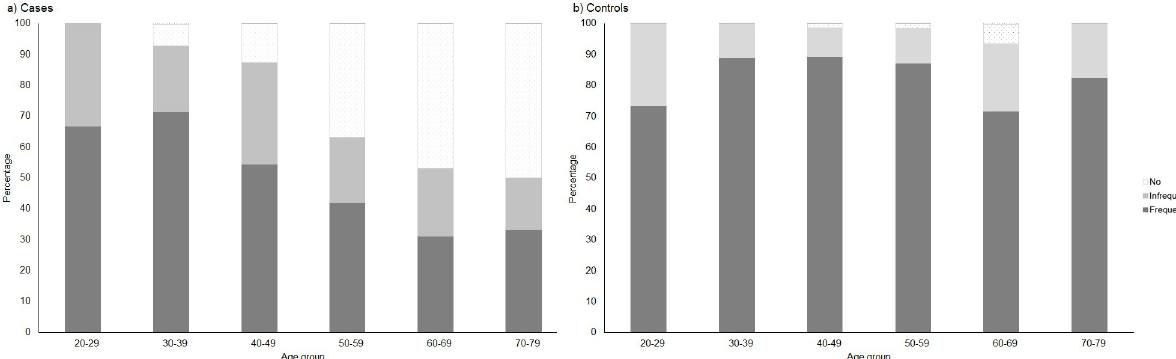
Fig 2. Participation in cervical cancer screening during the past ten years among cases and controls, according to age group. Frequent: at least every three years in the last ten years; infrequent: less frequently than every three years in the last ten years; no: no participation in the past ten years or no lifetime